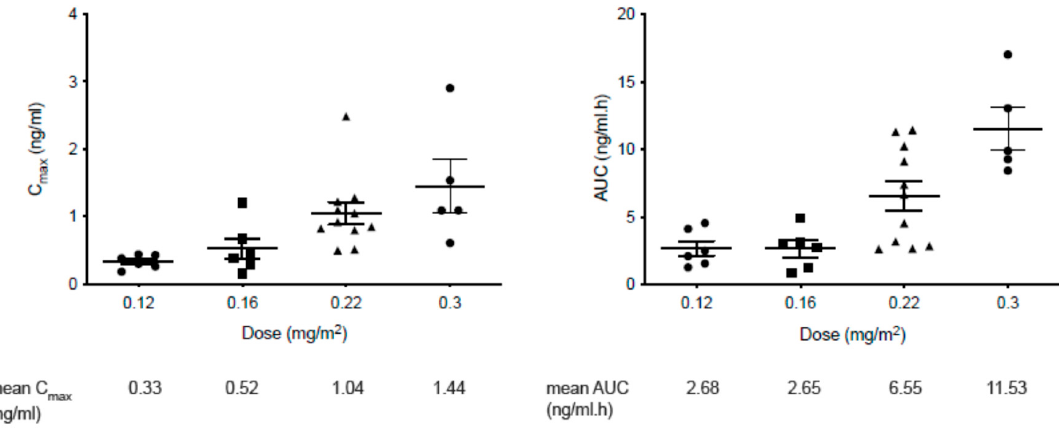
Figure 1. Topotecan mean peak serum concentration (C max ) and area under the curve (AUC) by dose level (as indicated by different shapes for data points within each dose level).